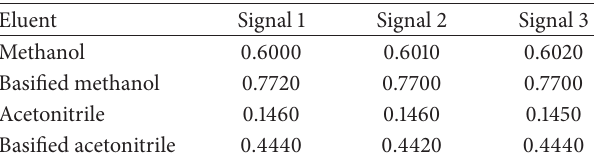
Table 3: Results of the evaluation of different systems for tartrazine elution.